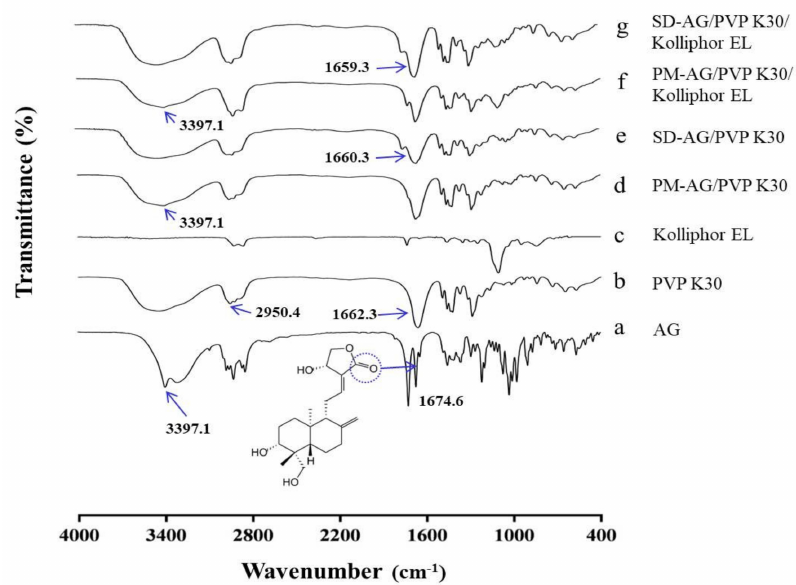
Figure 4. Fourier-transform infrared spectroscopy spectrums of: ( a ) andrographolide (AG); ( b ) PVP K30; ( c ) Kolliphor EL; ( d ) physical mixture (PM)-AG / PVP K30 (1:7, w / w ); ( e ) solid dispersion (SD)-AG / PVP K30 (1:7, w / w ); ( f ) PM-AG / PVP K30 / Kolliphor EL (1:7:1, w / w / w ); and ( g ) SD-AG / PVP K30 / Kolliphor EL (1:7:1, w / w / w